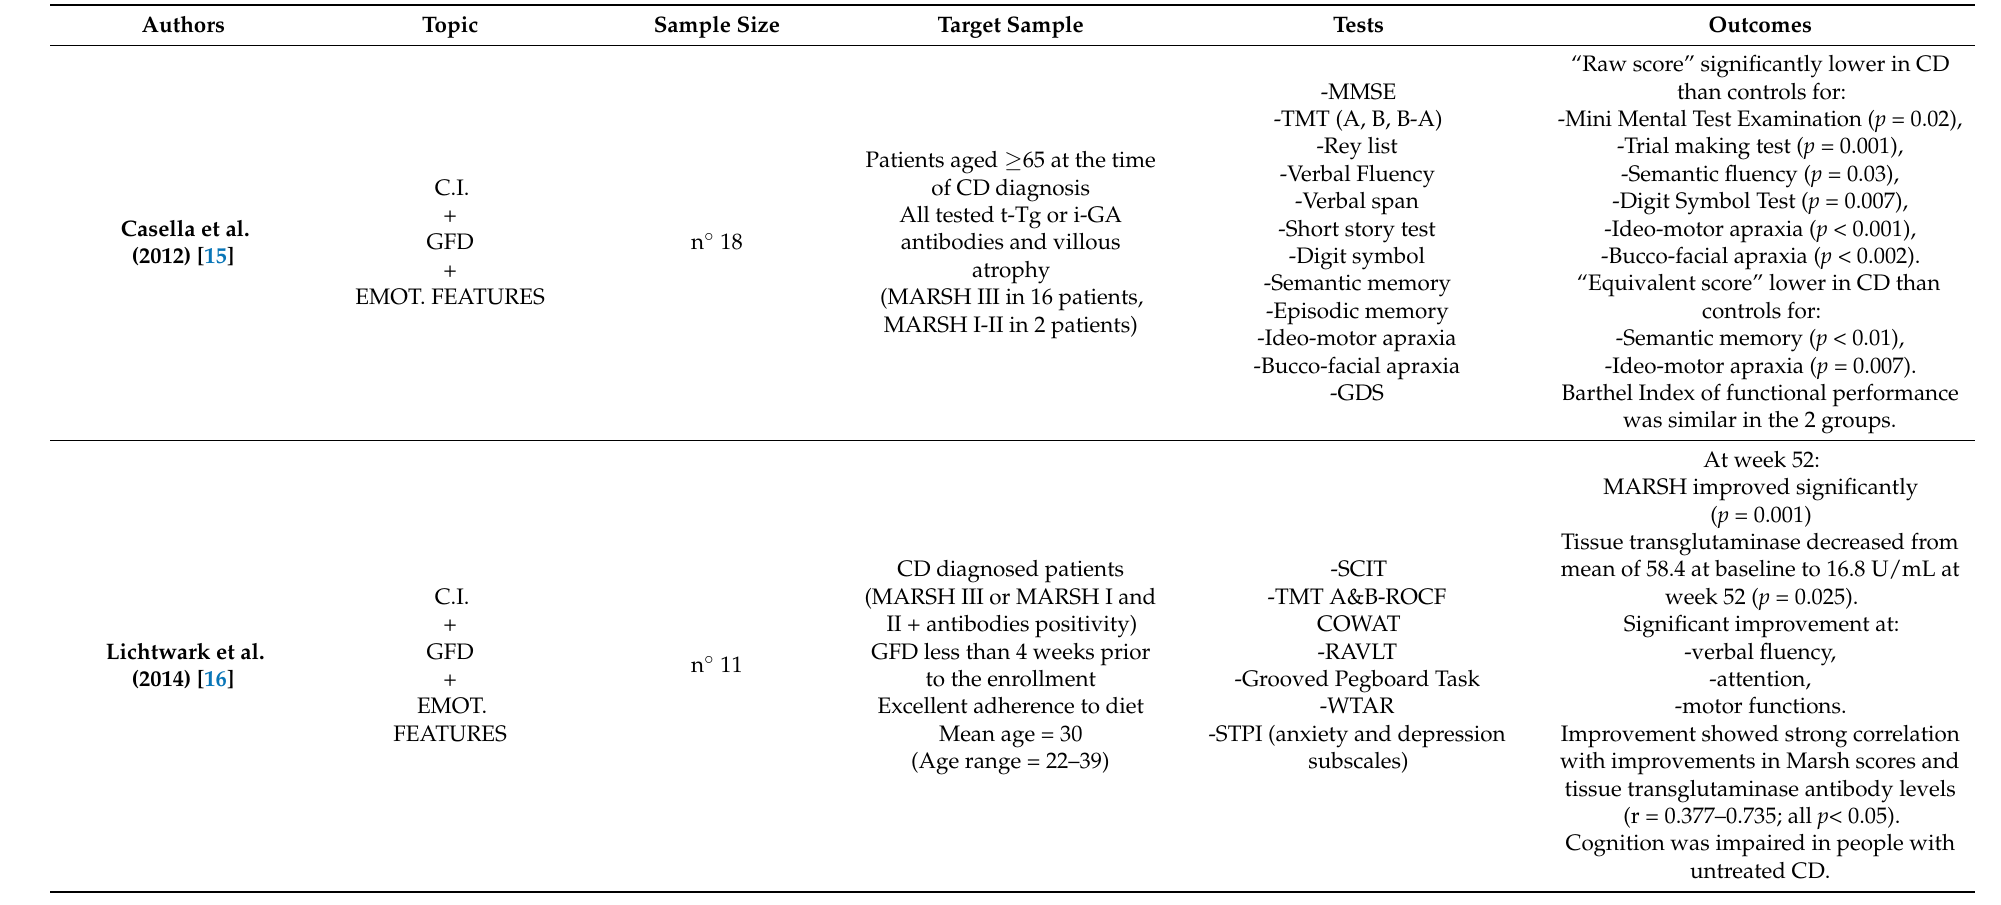
Table 2. Characteristics of the reviewed